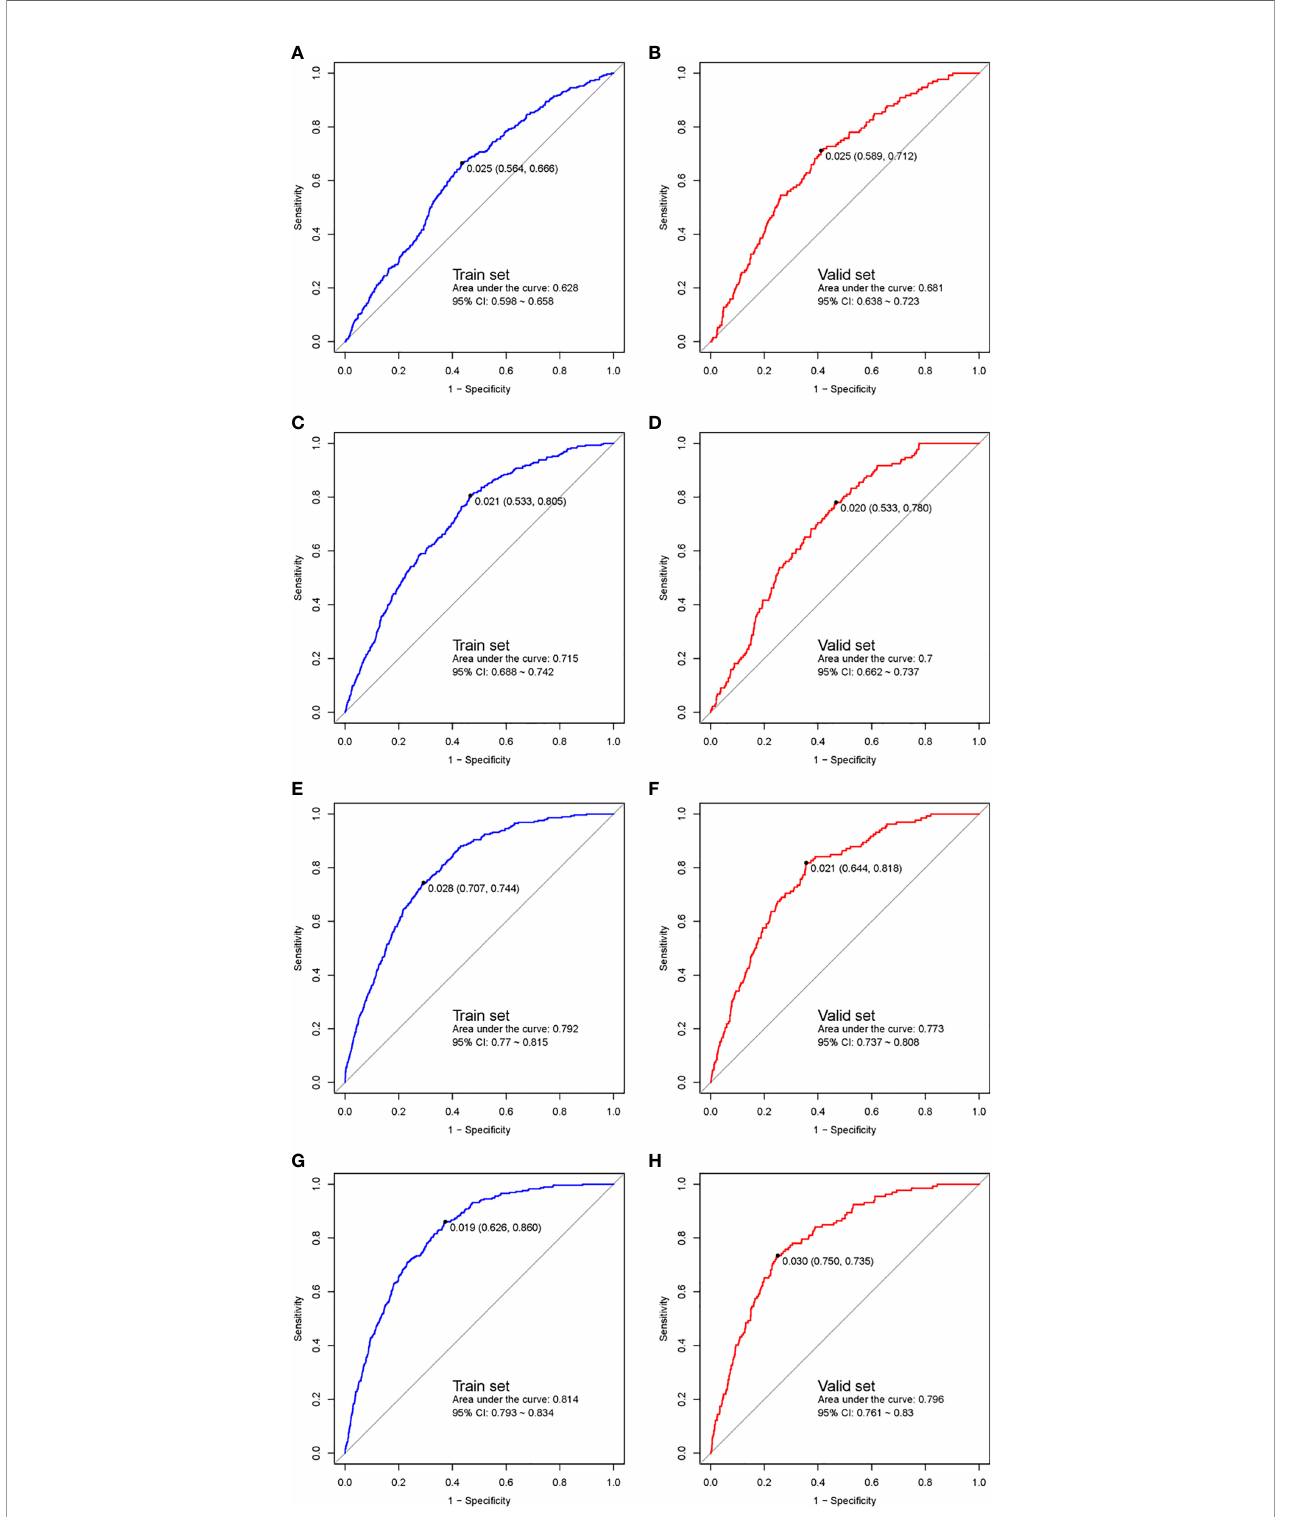
FIGURE 2 | ROC curves of the multiphase prediction models in the training cohort (left panel) and validation cohort (right panel). The fi rst phase (training cohort, A ; validation cohort, B ), the 2nd phase (training cohort, C ; validation cohort, D ), the 3rd phase (training cohort, E ; validation cohort, F ), and the fourth phase (training cohort, G ; validation cohort, H ). ROC, receiver-operator